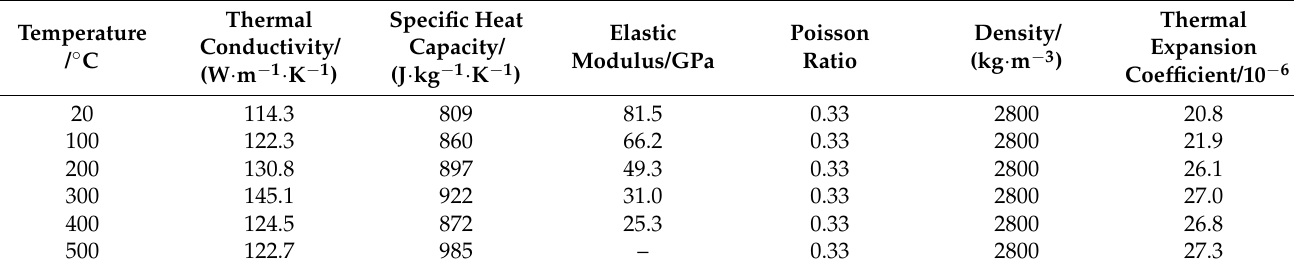
Figure 5. Yield strengths at different temperatures and plastic strains. Table 3. Thermal properties of 2A14 aluminum